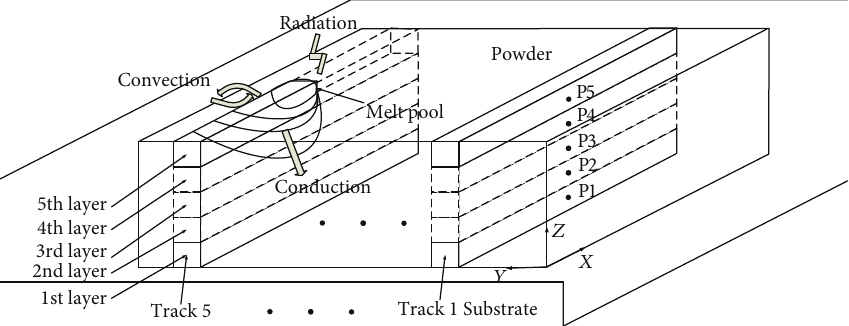
Figure 3: Schematic of multitrack and multilayer manufacturing during the SLM process.